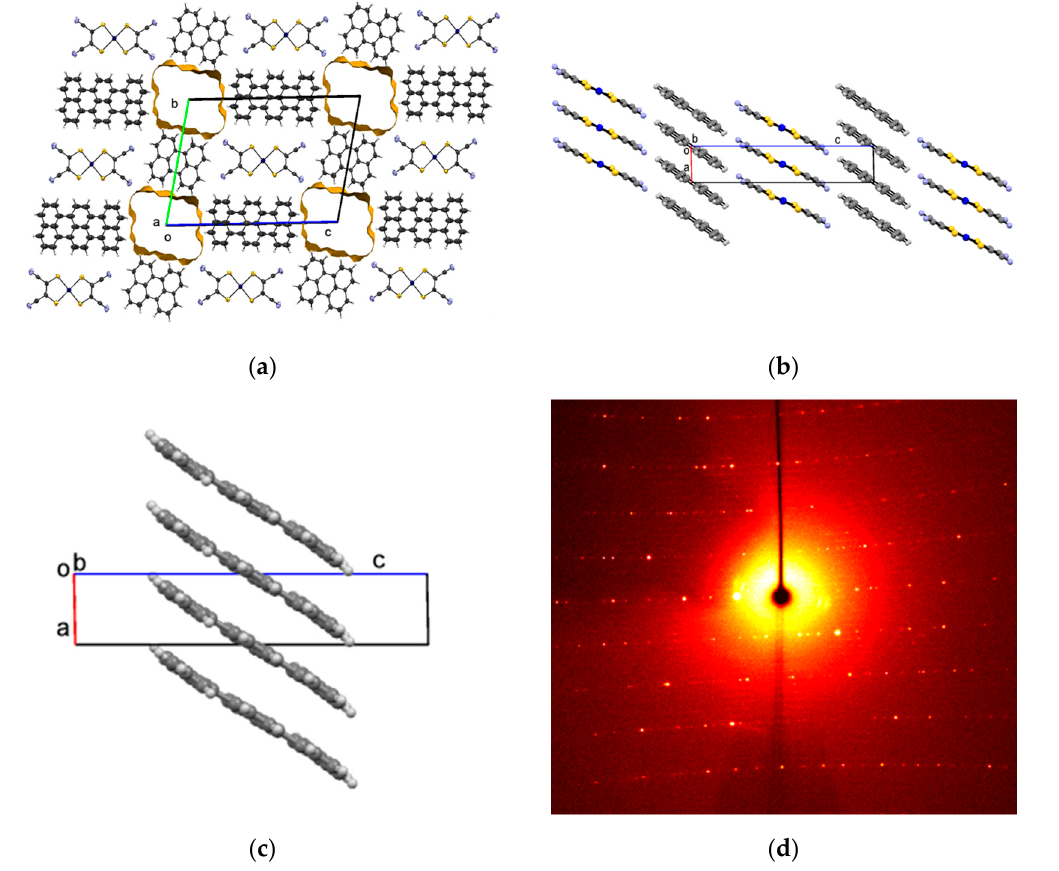
Figure 3. ( a ) Crystal structure of β‐ (Per) 2 [Pt(mnt) 2 ] viewed along the stacking a ‐ axis, with ordered layers of segregated perylene and [Pt(mnt) 2 ] stacks, alternating with disordered layers, in which only perylene molecules in two possible positions (50% occupation factors) could be devised; ( b ) Partial view along b of an ordered layer with parallel donor and acceptor stacks; ( c ) Partial view along b of a disordered stack of perylene molecules; ( d ) Diffraction pattern of β‐ (Per) 2 [Pt(mnt) 2 ] crystal (mochromatic synchrotron radiation, fixed film fixed crystal) showing diffuse scattering planes at ± na* /6 (vertical axis).